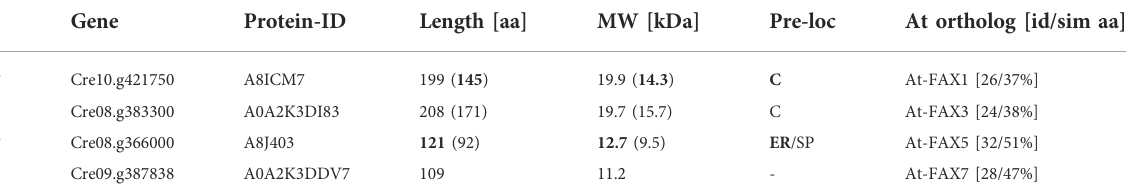
TABLE 1 FAX proteins in Chlamydomonas reinhardtii